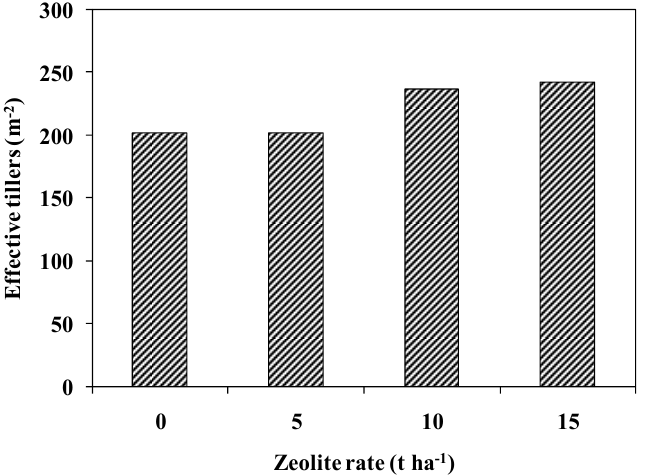
Figure 11. Effect of Zeolite Application on Tillering Pattern of Rice. Modified from Chen et al. [29].